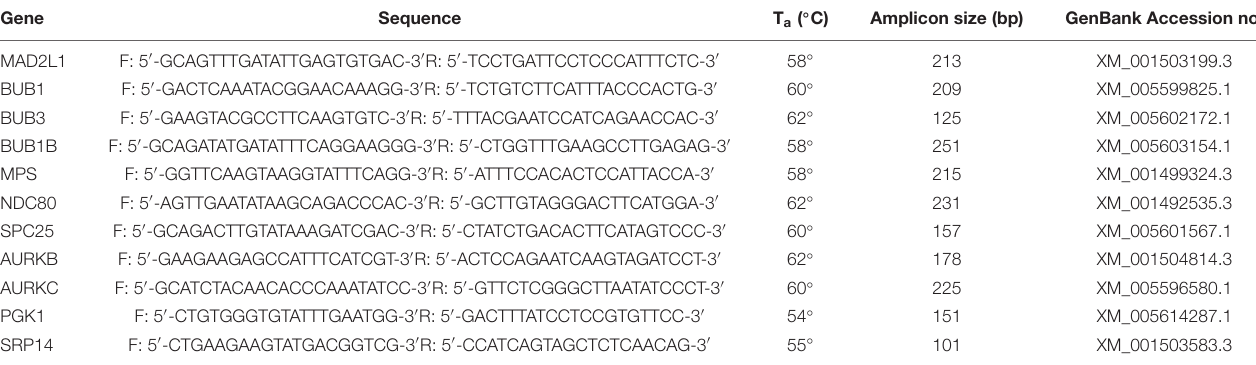
TABLE 3 | Details of the primer pairs for target and housekeeping genes used in the present study. Gene